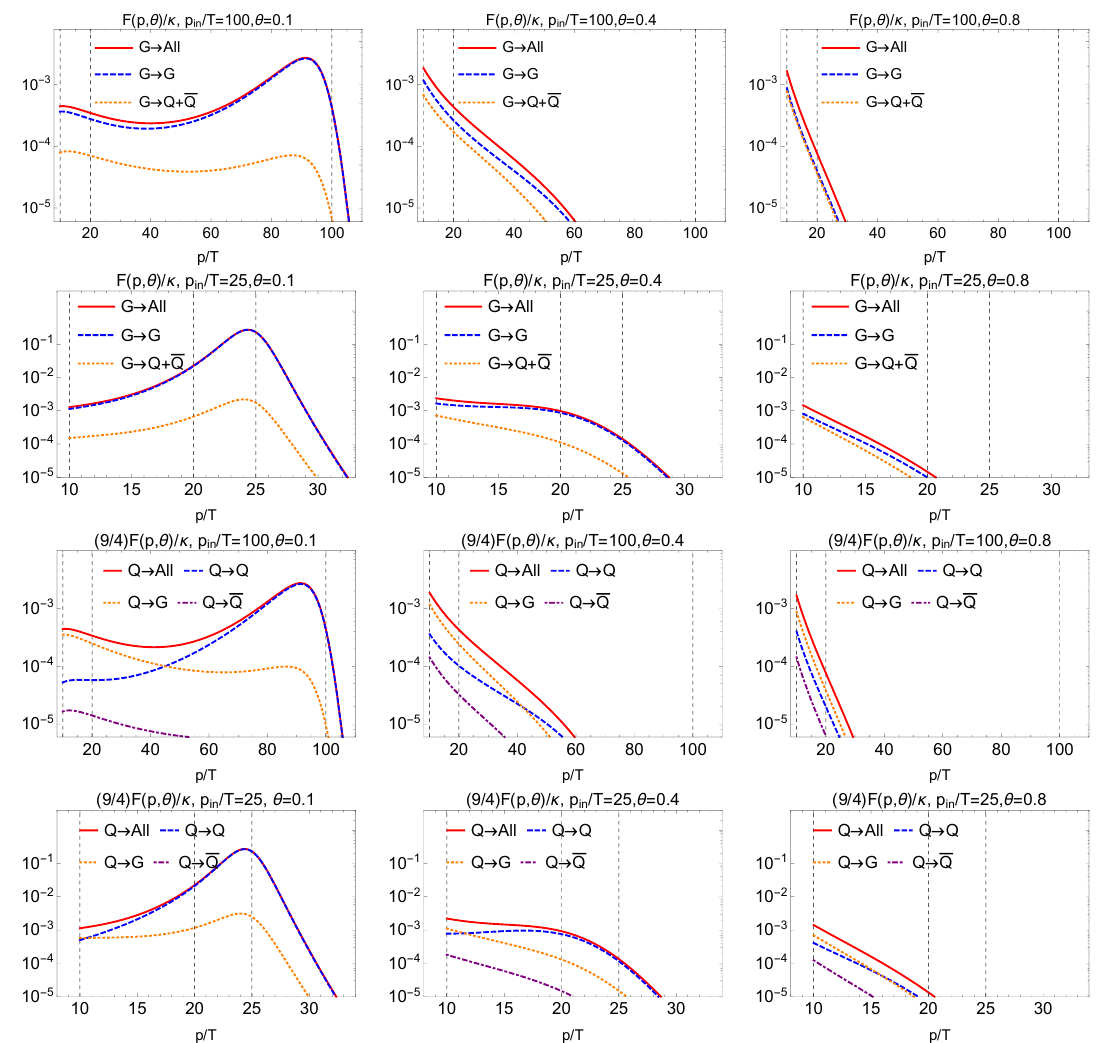
Figure 2 . The probability distribution F C ! all ( p; (cid:18) ) divided by (cid:20) = g 4 T (cid:1) t plotted as functions of p=T for an \incident gluon" with p in =T = 100 ((cid:12)rst row of panels) or p in =T = 25 (second row) and that for an \incident quark" with p in =T = 100 (third row) or p in =T = 25 (fourth row). From left to right, the columns correspond to choosing (cid:18) = 0 : 1, 0.4 and 0.8. Since we are considering a brick of QGP with net baryon number zero, F G ! Q ( p; (cid:18) ) = F G ! (cid:22) Q ( p; (cid:18) ), F Q ! G ( p; (cid:18) ) = F (cid:22) Q ! G ( p; (cid:18) ), F Q ! (cid:22) Q ( p; (cid:18) ) = F (cid:22) Q ! Q ( p; (cid:18) ), and F Q ! Q ( p; (cid:18) ) = F (cid:22) Q ! (cid:22) Q ( p; (cid:18) ). In the (cid:12)gure, the curves